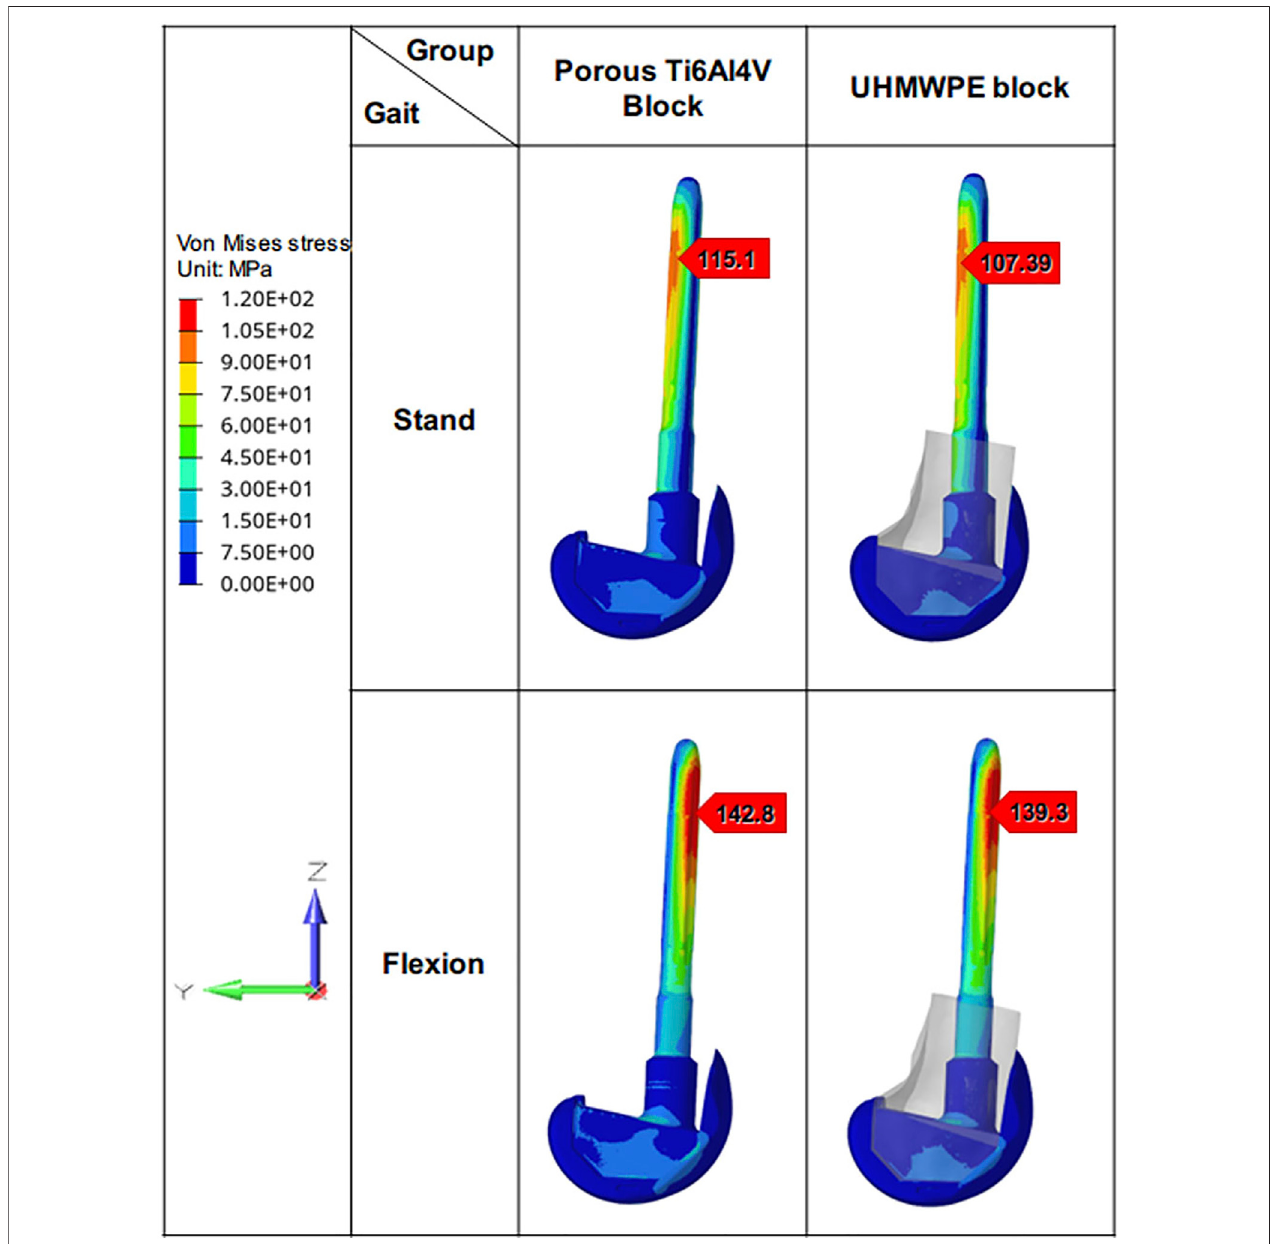
FIGURE 7 | Von Mises stress distribution of different prostheses. The Von Mises stress distribution on the prostheses and its maximum stress under different loading patterns.